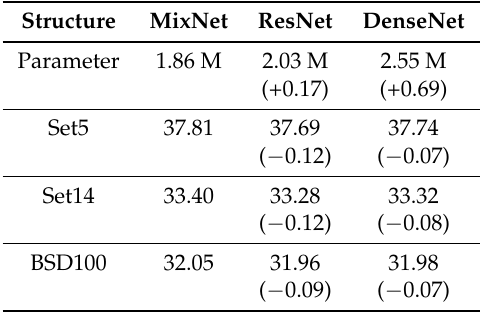
Table 2. Model parameter and performance on Set5, Set14 and BSD100 with different network